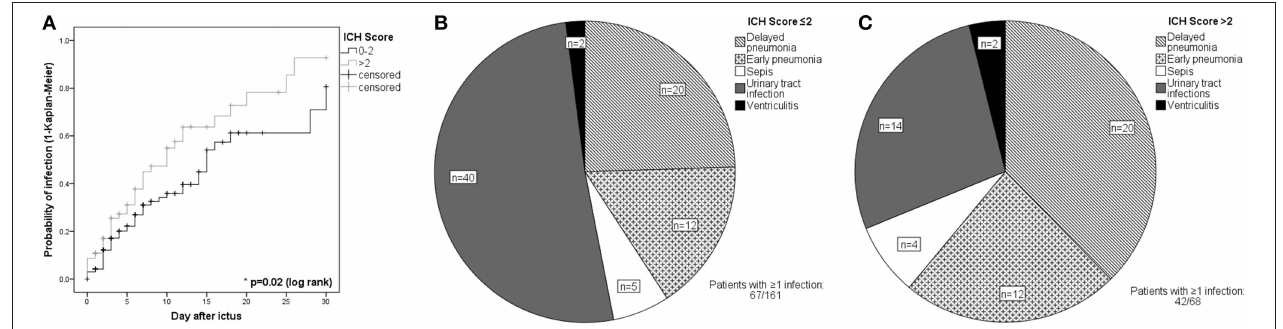
FIGURE 4 | (A) Kaplan-Meier-Curve describing the probability of any infectious complication in patients with ICH Score ≤ 2 and > 2. Patients were censored at the time of: withdrawal of care, NICU discharge, or death latest on day 30. Distribution of individual infections in patients with infections stratified by (B) an admission ICH Score ≤ 2 and (C) ICH Score > 2.